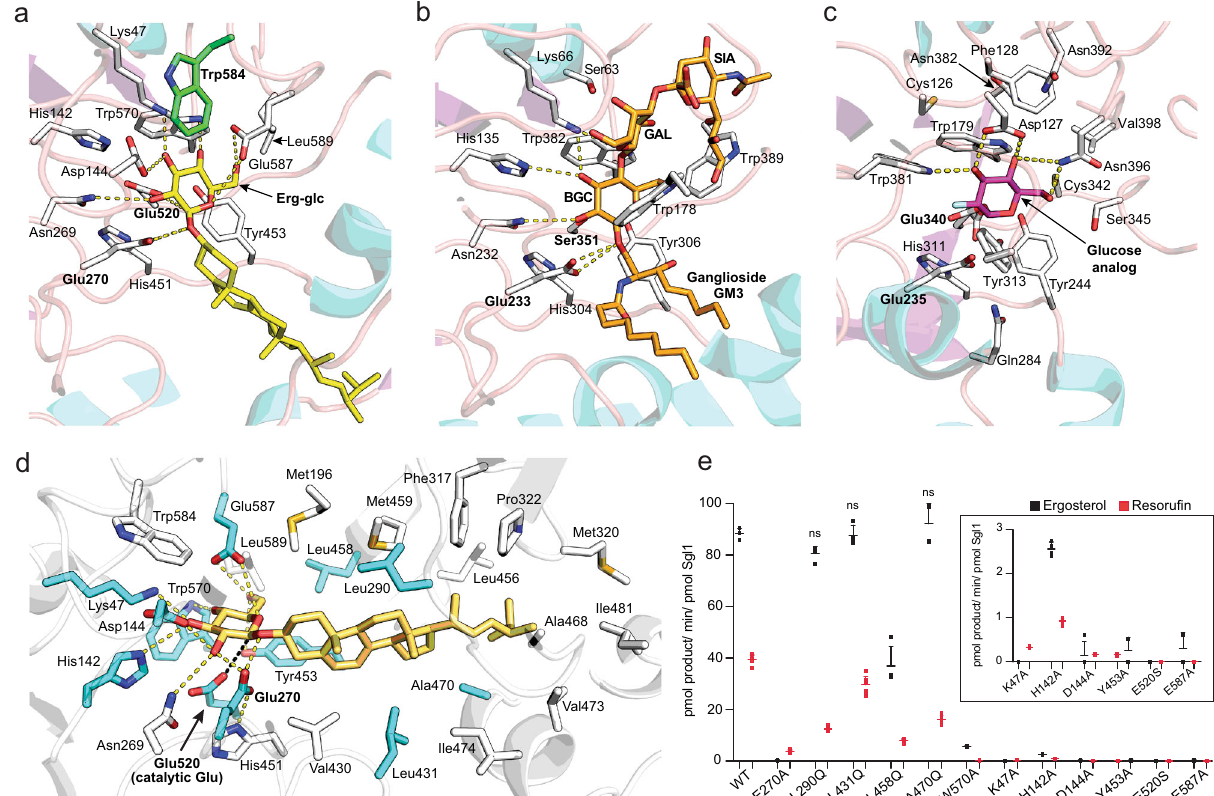
Fig. 3 Structural basis for sterylglucoside speci fi city. a Docking of erg-glc into Sgl1 shows the glucose in a similar position with EGCase II and Cerezyme, containing two catalytic glutamate residues, Glu270 and Glu520 (bold), found in the canonical topological positions of retaining β -glucosidases. Trp584 (green) provides steric hindrance to prevent the binding of multiple sugars and generate speci fi city for the single sugar of erg-glc. b EGCase II presented in the same view as Sgl1 highlighting the conserved glutamate residues Glu233 and Glu351 (bold). The point mutation E351S allowed co-crystallization of the protein – substrate complex. EGCase II has an unimpeded active site to hydrolyze gangliosides with multiple sugars. c Cerezyme co-crystallized with a glucose analog utilizes a distinct set of residues for glucose recognition, with a unique set of residues forming an active site cap for glucosylceramide speci fi city. d Docked erg-glc is recognized by several hydrogen bond contacts between residues Lys47, His142, Asn269, Glu270, Trp570, and Glu587 and the glucose moiety. The ergosterol moiety is surrounded by hydrophobic residues. Point mutants of green residues were generated to test their effects on erg-glc hydrolysis. e The point mutations of residues binding to the glucose moiety reduce or completely abolish Sgl1 activity towards the endogenous substrate erg-glc (black) or the arti fi cial substrate res-glp (red) ( p < 0.001). The inset graph diplays a zoomed in view of the residues with the lowest catalytic activities. Four residues around the ergosterol moiety were mutated to glutamine. L458Q reduces Sgl1 catalytic activity towards erg-glc and res- glp ( p < 0.001), while L290Q, L431Q, and A470Q do not affect Sgl1 activity towards erg-glc ( p > 0.05). Data represent the mean ± SD for n = 4 independent experiments with erg-glc and n = 8 with res-glp. Statistical analysis by one-way ANOVA, Dunnett ’ s multiple comparison test. Source data are provided as a Source Data fi Leu290, Leu431, or Ala470 were substituted with glutamine (Fig. 3e). Leu458 is close to the predicted glucose-binding site (Fig. 3d), which may explain the reduction of activity in comparison to the other residues that simply line the hydro- phobic pocket. Together, this suggests the hydrophobic pocket of Sgl1 displays plasticity to accommodate the glutamine residues without loss of activity. Consistent with this, Leu431 and Ala470 residues in some Sgl1 homologs (Supplementary Fig. 3).